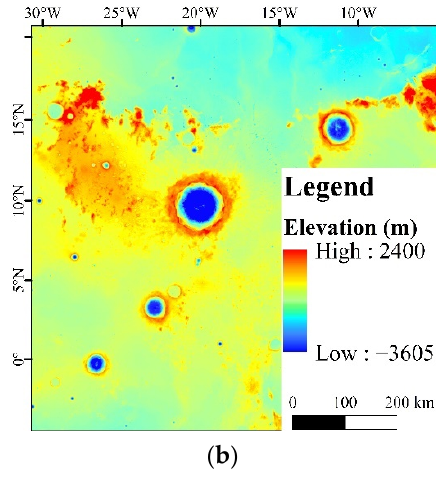
( c ) Figure 1. Copernicus crater and the surrounding area. ( a ) Copernicus area on a LROC WAC Global Morphology Mosaic; ( b ) Copernicus area on a LROC WAC DTM GLD100; ( c ) Copernicus area on a “Unified Geologic Map of the Moon, 1:5M, 2020”. 2. Data and Methods 2.1. Datasets In this study, we make use of a high-resolution gravity field model of the degree and order 1200 in spherical harmonics, obtained by NASA’s Gravity Recovery and Interior Laboratory mission (GRGM1200A) [25]. A digital elevation model (DEM), created by Lu- nar Orbiter Laser Altimeter (LOLA) and SELenological and Engineering Explorer (SE- LENE) Kaguya Team called Moon LRO LOLA-SELENE Kaguya TC DEM Merge(59 m/pixel) [26] and Chang’e-2 digital orthophoto map (CE2 DOM, 7 m/pixel) show the high- resolution topography. The Kaguya TC Ortho Mosaic Global image (7.4 m/pixel) helps to analyze the morphology and chronology of the C-H basin. Olivine and optical maturity (OMAT) parameter images (59 m/pixel) from Kaguya MI, are also used [27]. Some olivine- bearing places, such as the Copernicus central peaks, represent an olivine lithology occur- ring at depth [28] and high regional olivine contents might show the existence of basalts in the western mare [29]. The OMAT is the degree to which a particular lunar soil pos- sesses the quantitative characteristics consistent with that exposure [30]. It shows the time that the lunar surface was exposed to the space environment to distinguish the type of surface. In addition, the “Unified Geologic Map of the Moon, 1:5M, 2020” from NASA, is used to learn the geology background of the research area [31]. The Moon LRO LROC WAC Global Morphology Mosaic (100 m/pixel) and Moon LROC WAC DTM GLD100